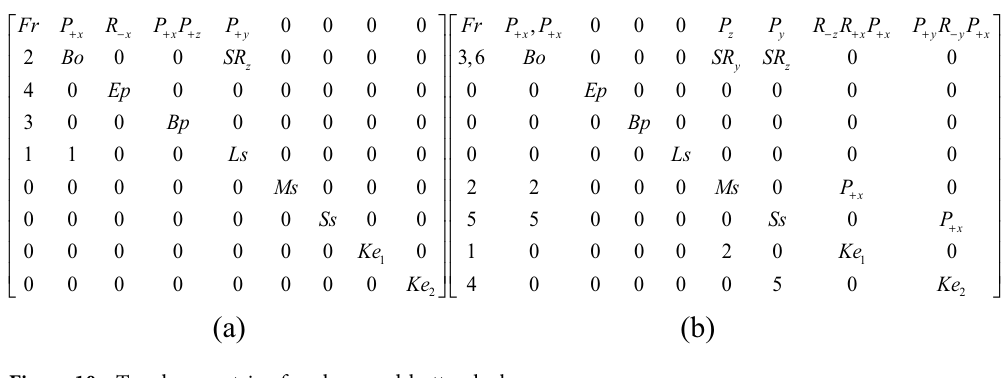
Figure 10. Topology matrix of push up end-button